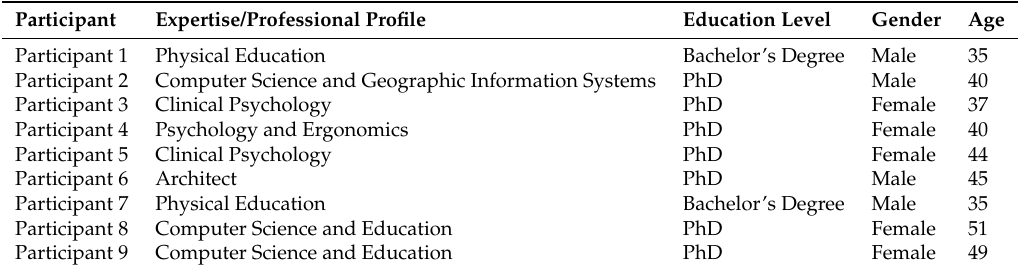
Table 1. Sociodemographic data of the participants of the focus group one.